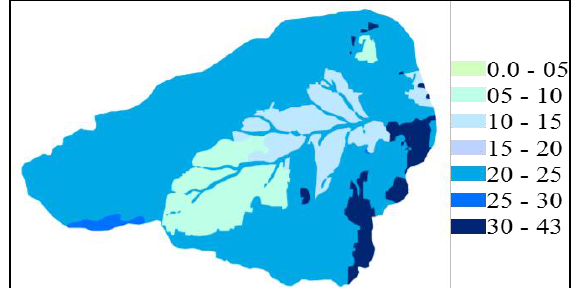
Figure 7. Sub-catchment runoff values